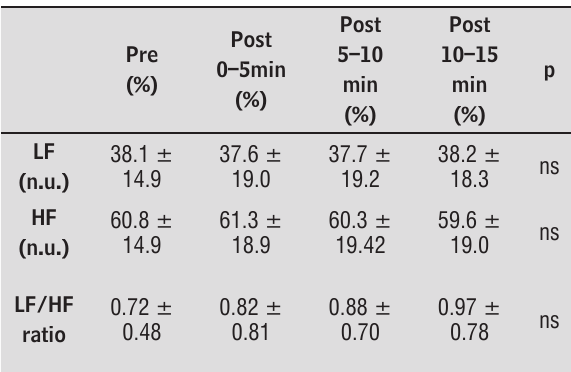
Note: LF = low frequency; HF = high frequency; n.u. = normal- ized units.